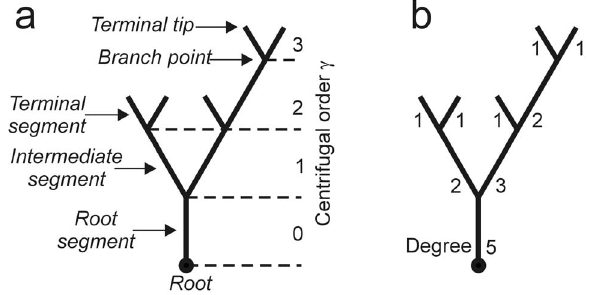
Figure 1. Schematic neuritic trees illustrating tree terminology. a , The different segments and nodes that can be distinguished and the labeling of segments based on centrifugal order. The centrifugal order of a segment is the number of branch points along the path from the root to the terminal tip of the segment. Terminal tip is equivalent to growth cone. b , Labeling of segments based on degree. The degree of a segment is the number of terminal tips in the (sub) tree carried by the